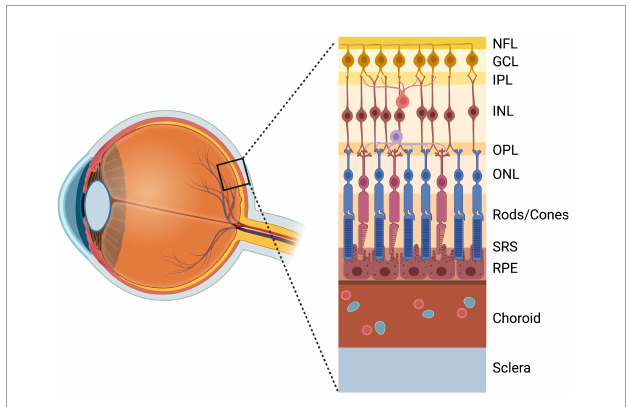
FIGURE1 Anatomy of the retina anterior to posterior: NFL, nerve fiber layer; GCL, ganglion cell layer; IPL, inner plexiform layer; INL, inner nuclear layer; OPL, outer plexiform layer; ONL, outer nuclear layer; Photoreceptor layer (Rods/Cones); SRS, subretinal space; RPE, retinal pigment epithelium; Choroid; Sclera. Created with